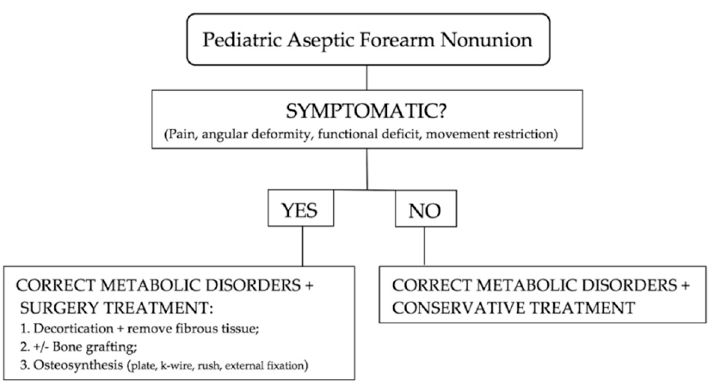
Figure 4. Treatment algorithm for pediatric aseptic forearm nonunion.